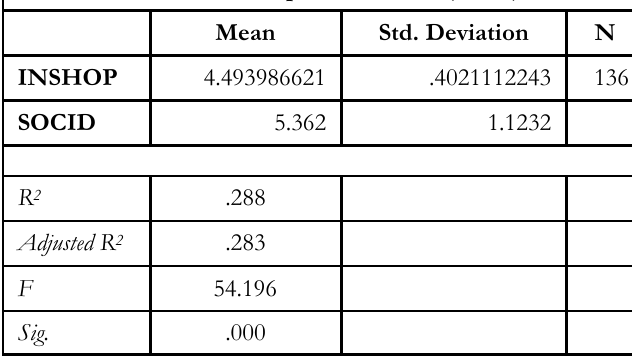
Table 5: Descriptive Statistics (Rural)